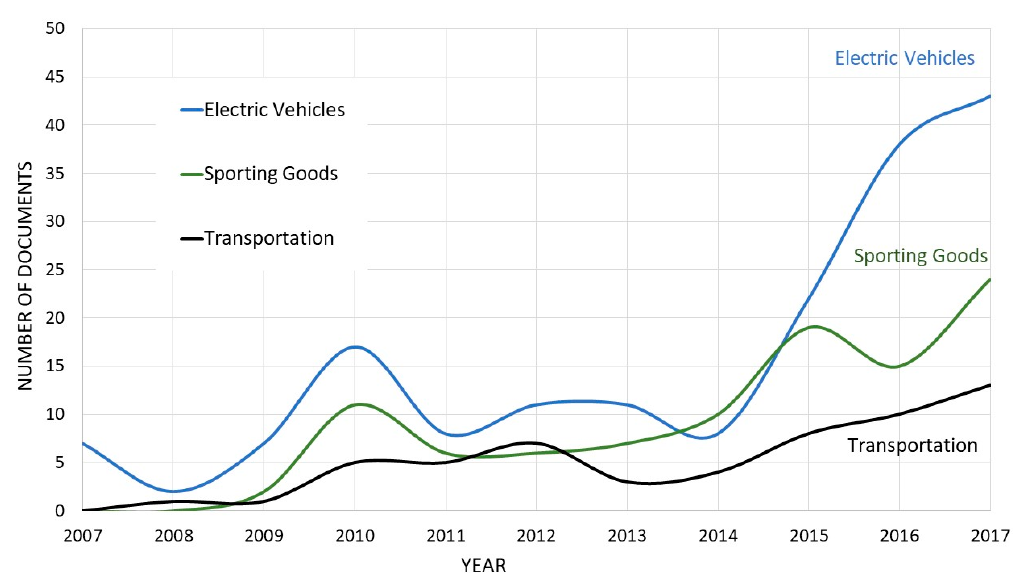
Figure 7. Evolution of the top three keywords related to electric bicycle.